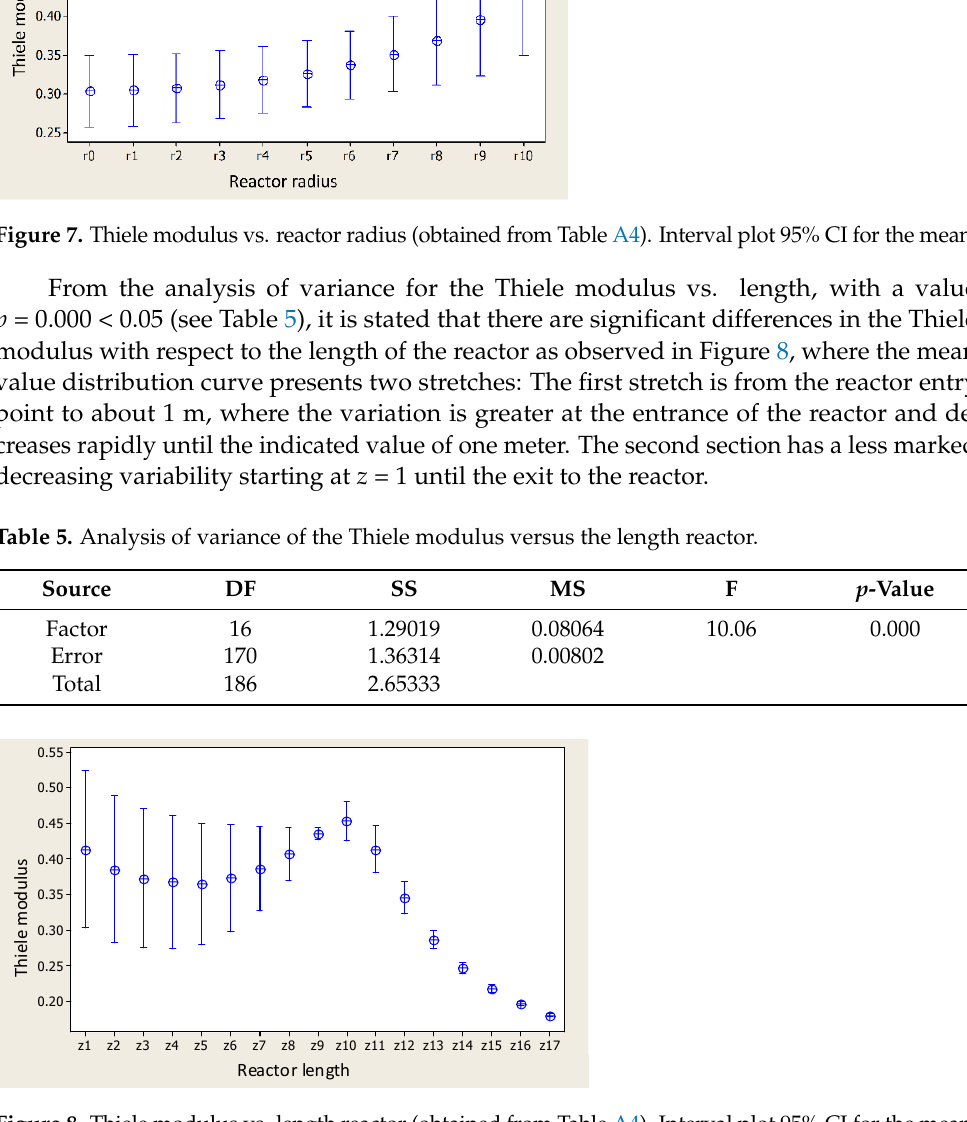
Figure 8. Thiele modulus vs. length reactor (obtained from Table A4). Interval plot 95% CI for the mean. Table 5. Analysis of variance of the Thiele modulus versus the length reactor.